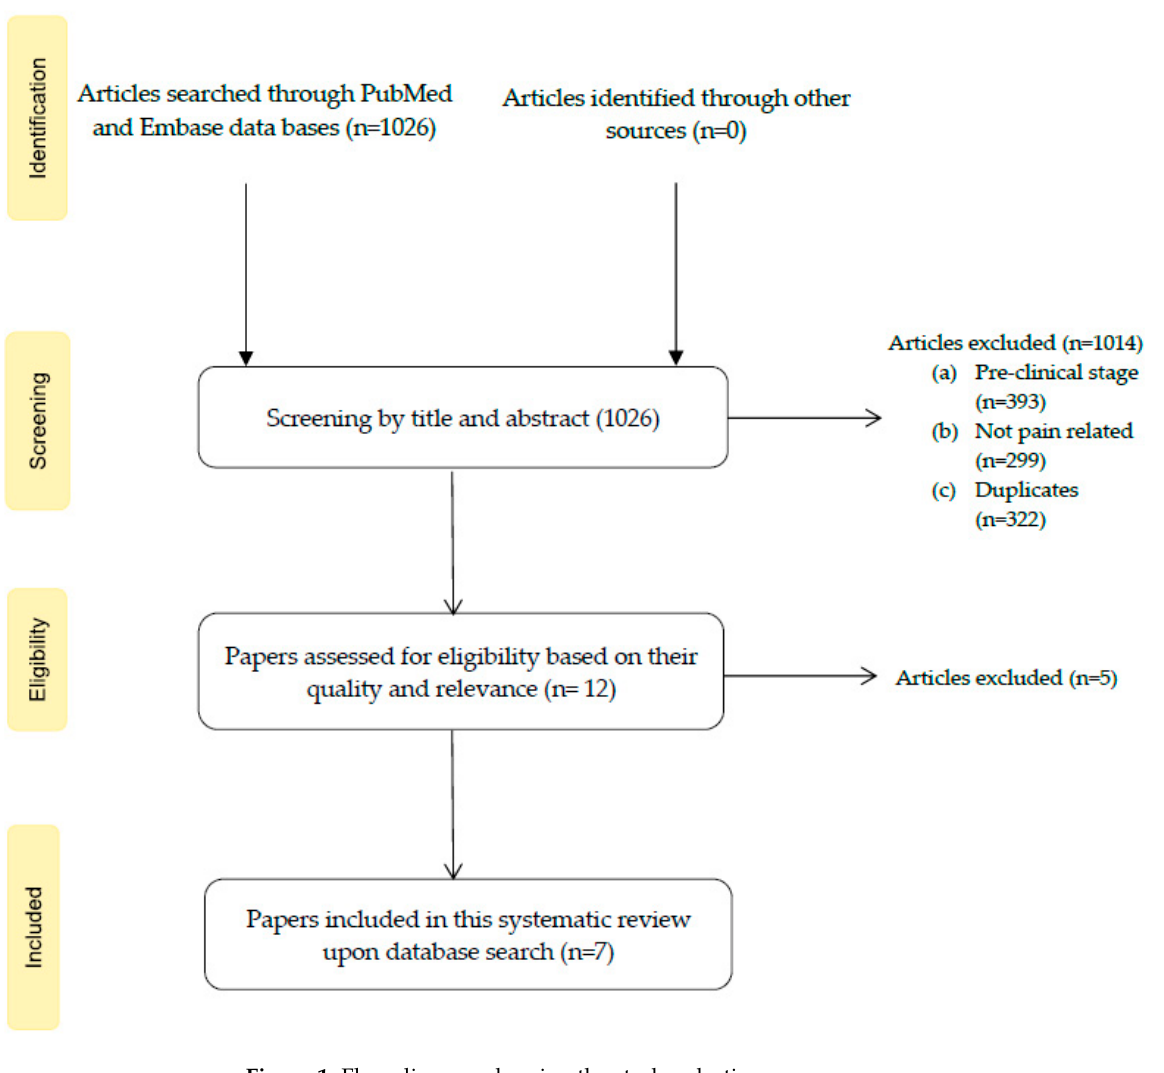
Figure 1. Flow diagram showing the study selection process.